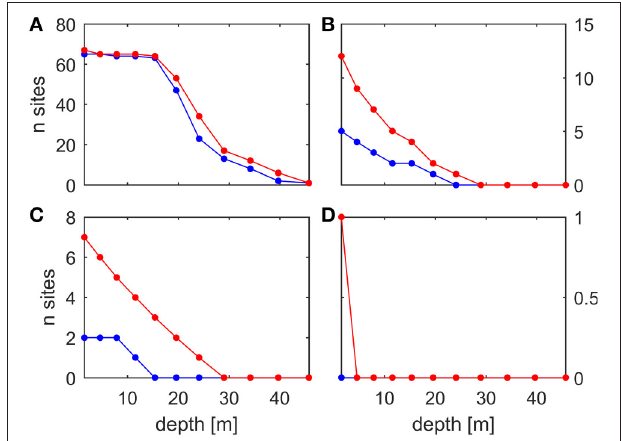
FIGURE 4 | Present (blue) and future (red) number of sites among the considered presence records where each MHW occurred at least once. (A): 25 ◦ C × 12 days threshold, presence records for C. rubrum . (B) 28 ◦ C × 15 days threshold, presence records for M. galloprovincialis . (C) 28 ◦ C × 30 days threshold, presence records for M. galloprovincialis . (D) 30 ◦ C × 20 days threshold, presence records for M. galloprovincialis . For the sake of completeness, we include all of the depth levels, so the very shallow data points in (A) are not actually relevant for C. rubrum and the deep data points in (B–D) are not actually relevant for M. galloprovincialis